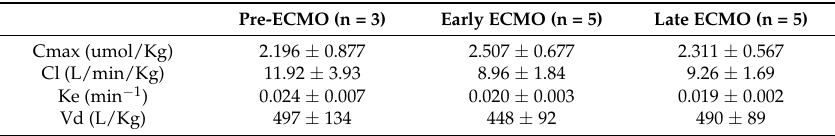
Figure 2. Curves showing the maximum concentration (Cmax) of meropenem (%) versus time. Maximum concentration of meropenem was 131 ± 59 M, 154 ± 52 M and 137 ± 27 M for Pre-ECMO, Early ECMO and late ECMO, respectively. Table 1. Pharmacokinetics of meropenem at different periods. Cmax: maximum concentration; Cl: clearance of meropenem and Vd: volume of distribution. Values are expressed as mean ± SEM ANOVA test * p >